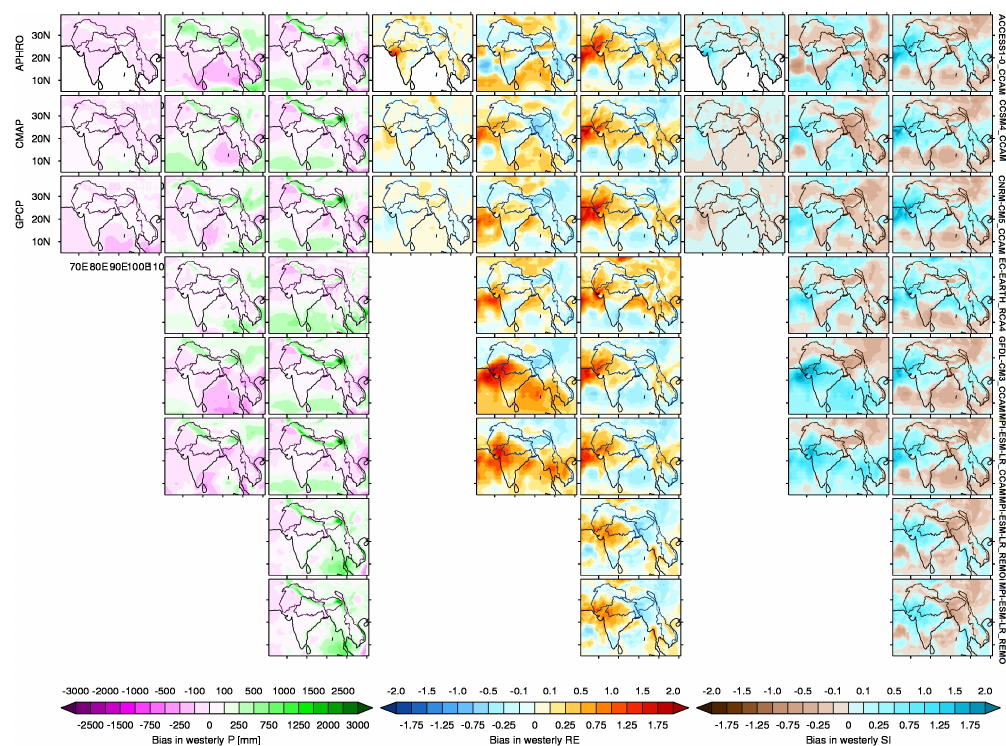
Figure 9. Same as Figure 8, but for the westerly precipitation regime.